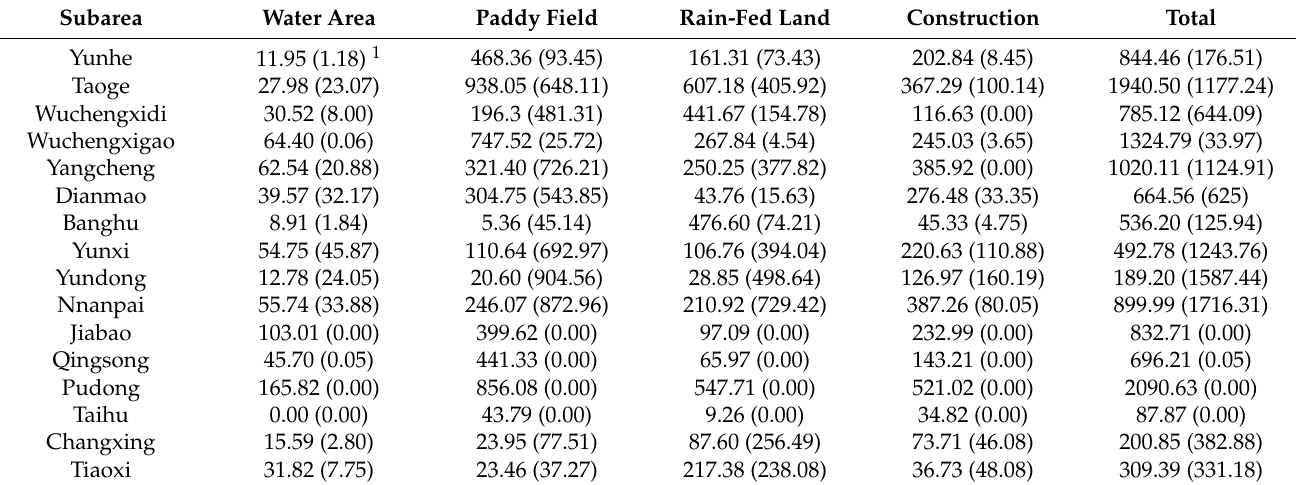
Table 3. The digital area of four kinds of underlying surface (outside and inside of polder area). Subarea